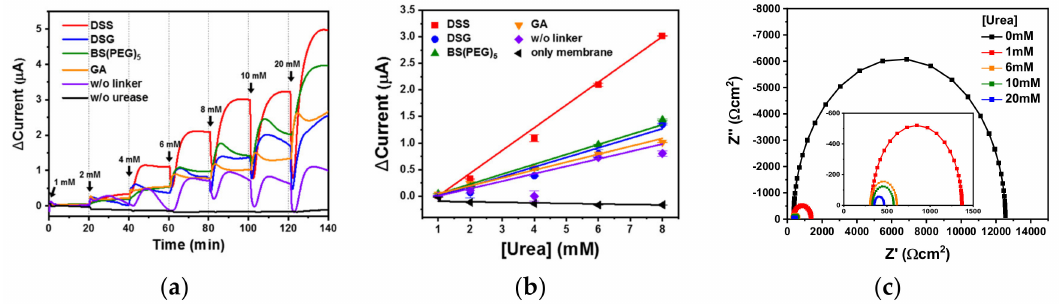
Figure 5. ( a ) Real-time monitoring of urea-spiked phosphate bu ff ered saline (PBS) using the urea biosensors under flow conditions and ( b ) the biosensor response and ( c ) Nyquist plots according to changing urea concentration.